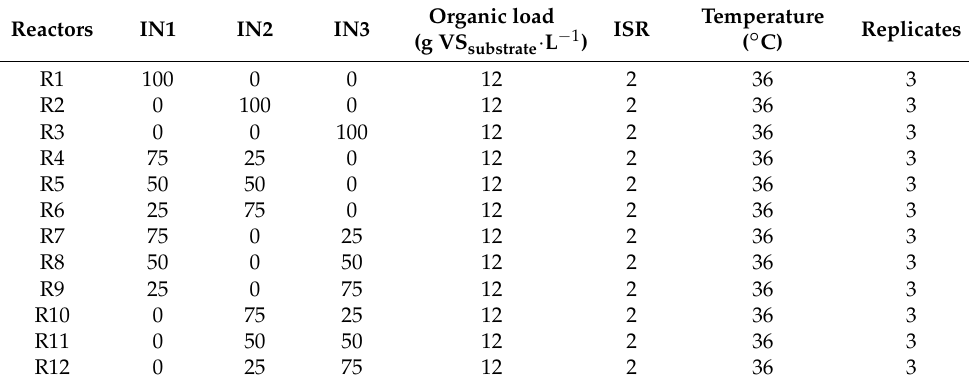
Table 2. Process conditions applied in the batch